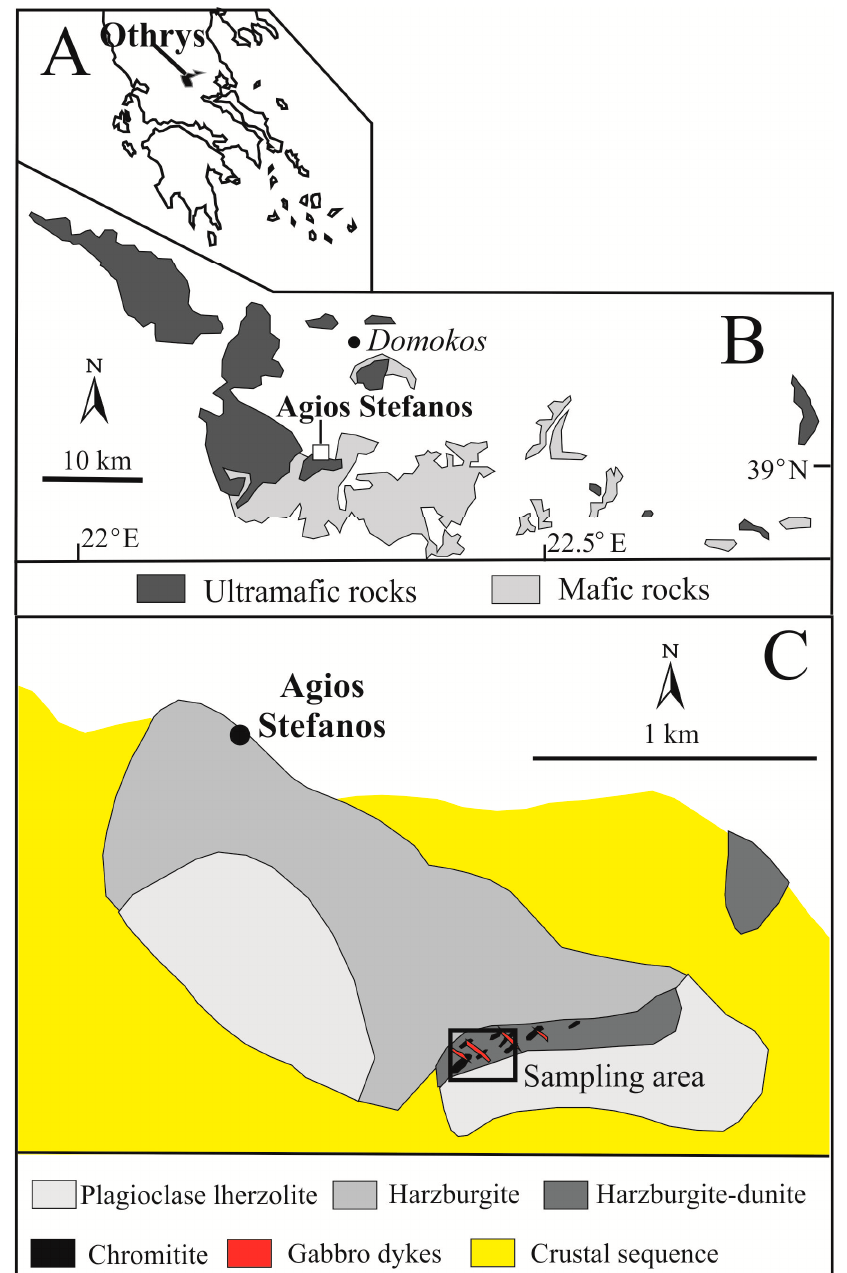
Figure 1. Location of the Othrys complex in Greece ( A ), general geological map of the Othrys ophiolite showing location of the Agios Stefanos chromium mine ( B ), and ( C ) detailed geology of the Agios Stefanos area (modified after [19] and [16]).